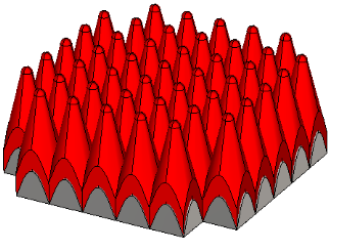
The coated cone is made of brass and installed on the bottom plate, and its gap is filled with thermal conductive silicone grease. To minimize heat loss, the coated cone array is surrounded by an outer shell and the bottom is covered with thermal insulation material. The corresponding diagram of the coating cone array is shown in Figure 8.